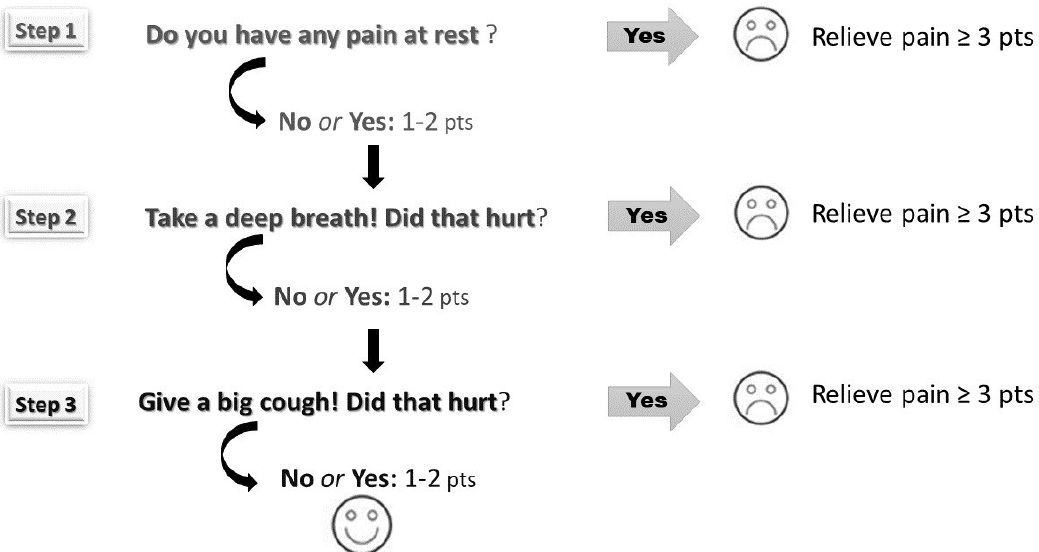
Figure 1. The three-step pain assessment method (pain was assessed at rest, during deep breathing and coughing according to Numerical Rating Scale ranging from 0 points to 10 points).